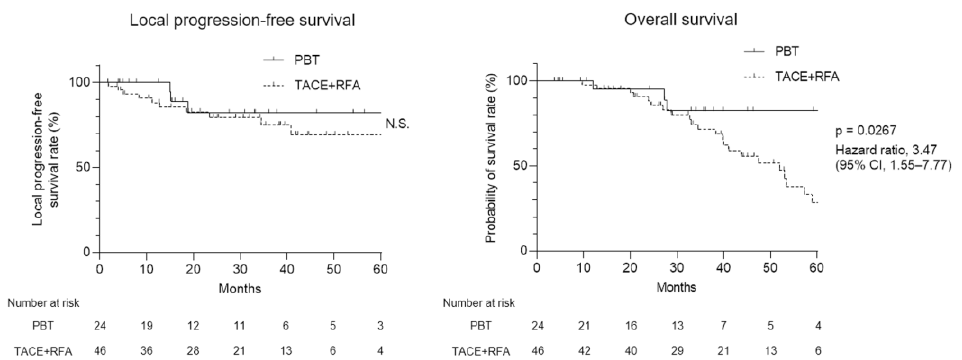
Figure 2. Local progression-free survival (PFS) and overall survival (OS) of PBT and TACE + RFA treatment for patients with HCC. ( left ) Kaplan–Meier curves of local PFS and ( right ) OS for PBT and TACE + RFA treatment for patients with HCC. CI, confidence interval; HCC, hepatocellular carcinoma; PBT, proton beam therapy; PFS, progression-free survival; OS, overall survival; TACE, transcatheter arterial chemoembolization; RFA, radiofrequency ablation; N.S., not significant.